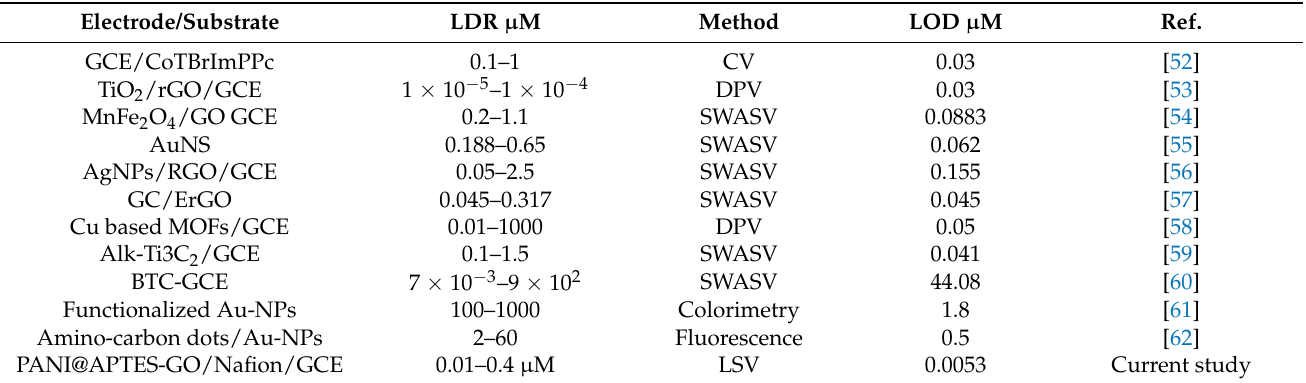
Table 2. Comparison of current research work with some of the previous work.